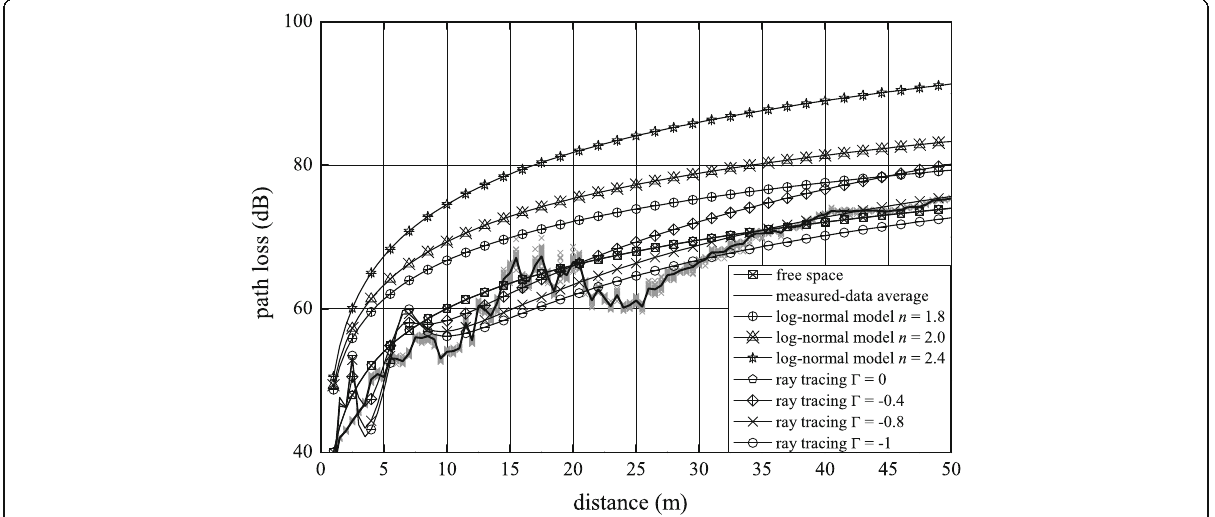
Fig. 7 Path loss of the free space model and developed propagation model of the second case with 1-m antenna height above the